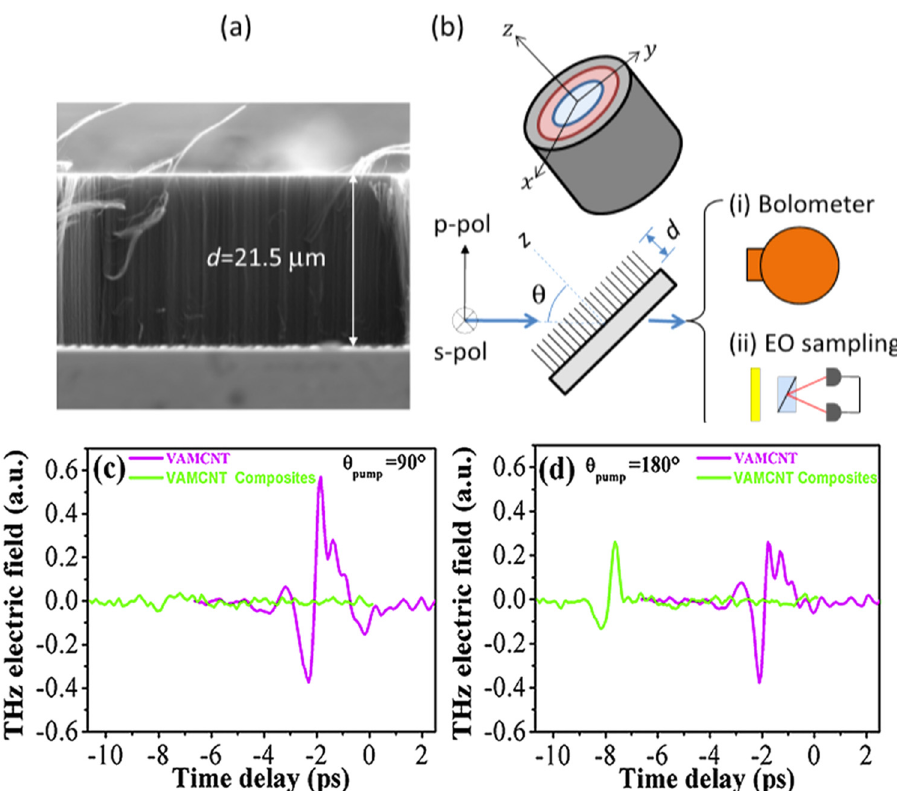
Figure 14: ( a ) SEM image of the VACNT sample and the fi lm thickness is 21.5 µm. ( b ) Ellipsometry schematic for THz emission measurements: linearly polarized, broadband pulses are incident upon a VACNT fi lm. THz detection scheme: ( i ) integrated power spectrum measured with a Si - bolometer and ( ii ) THz measured with electro - optic ( EO ) sampling [ 106 ] Copyright 2012, American Institute of Physics. ( c ) Emitted THz domain waveform from the VACNT and the pure quartz substrate. ( d ) A comparison of the emitted THz waveform from VACNT fi lm and VACNT composite fi lm [ 107 ] . Copyright 2018,